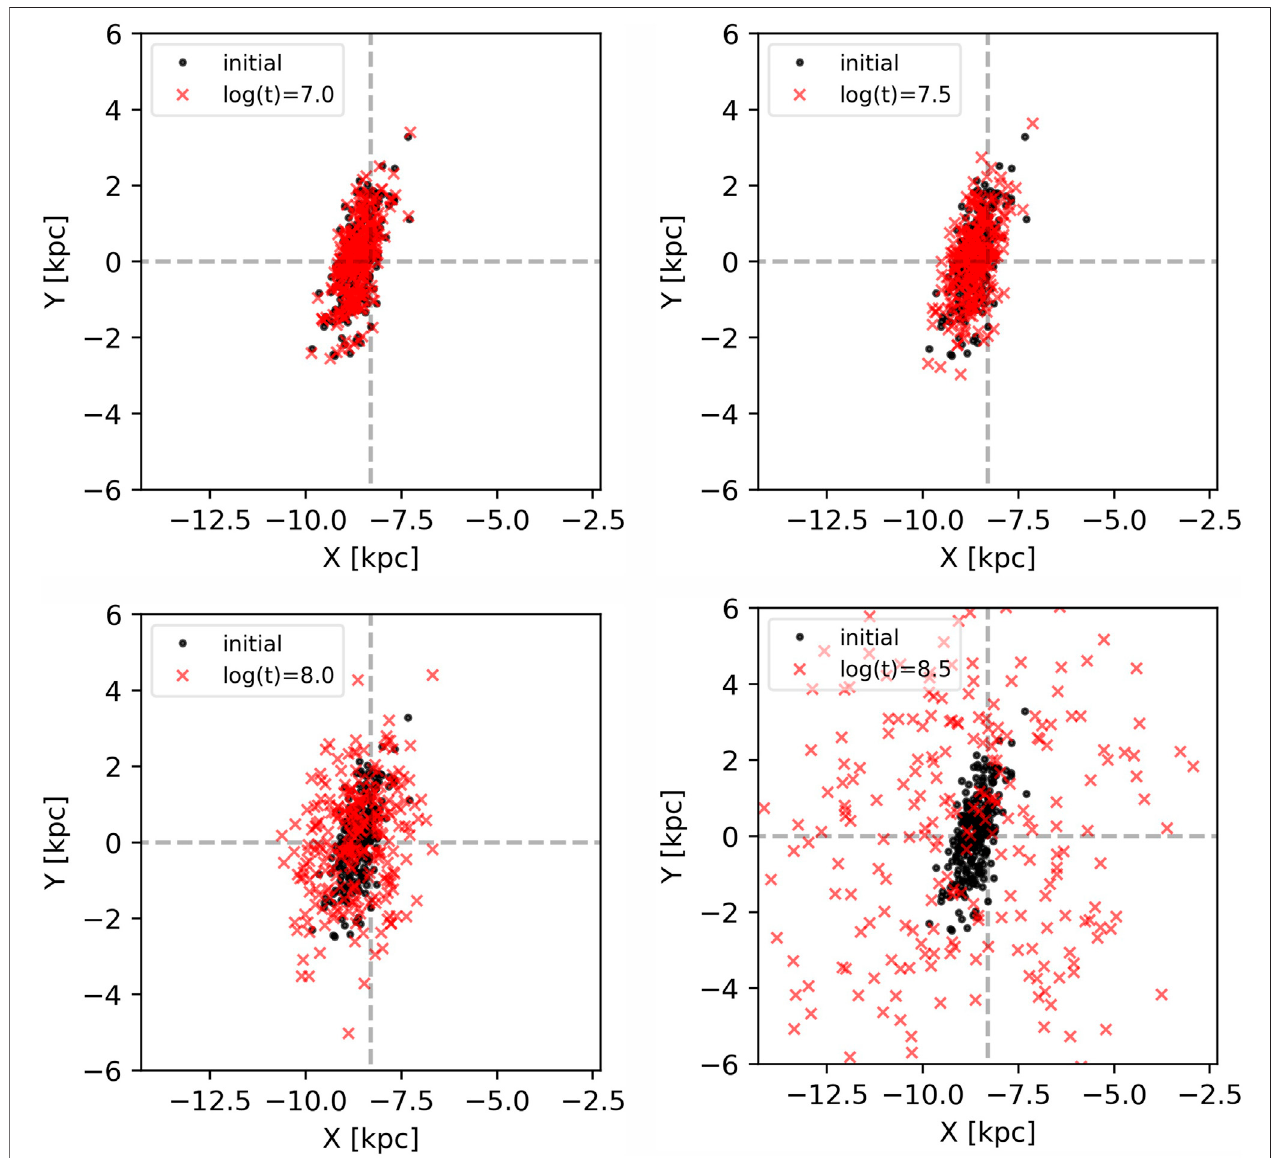
FIGURE 8 | Breaking of the spiral pattern in the distribution of open clusters due to the dispersion of velocities introduced in the rotating frame of reference. As we discussed in the text, this situation is not physical. However, it still provides us with statistical information — even relatively small deviations from the orbital velocity ( ∼ 10 km/s) of the spiral arm would cause a breaking of the